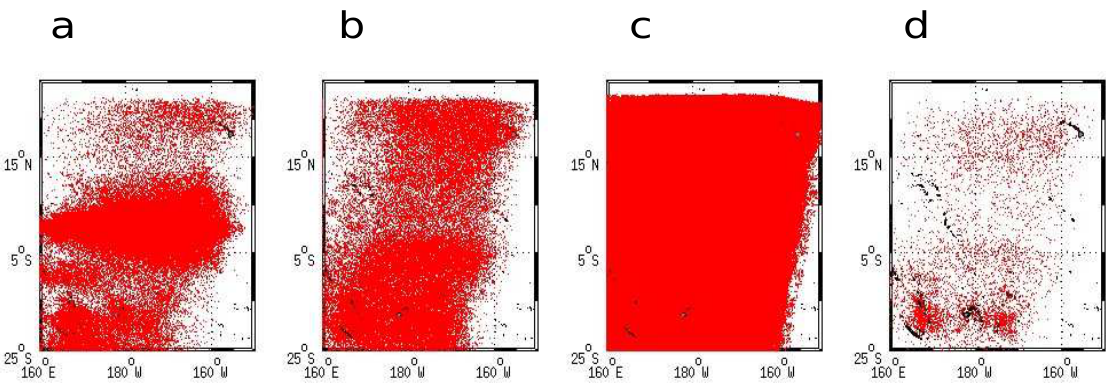
Fig. 4. Application of the TRICHOSAT algorithm to satellite data (1997 to 2010) over the large box corresponding to the Western Pa- cific Ocean (WP: 25 ◦ N–25 ◦ S/160 ◦ E–160 ◦ W) for the interseason (April–May and October) (a) all pixels for which Chl- a > 0.2mgm − 3 ; (b) pixels satisfying the slope and intercept criteria of the RAS; (c) pixels satisfying the shape criteria, (d) pixels satisfying all criteria. The main islands of New Caledonia at 20 ◦ S, Vanuatu at 15 ◦ S, Fiji Islands at 17 ◦ S, Hawaii Islands at 20 ◦ N are indicated in black Fig. 4d. Yt (0.9725–1.0175) characterized Trichodesmium pixels